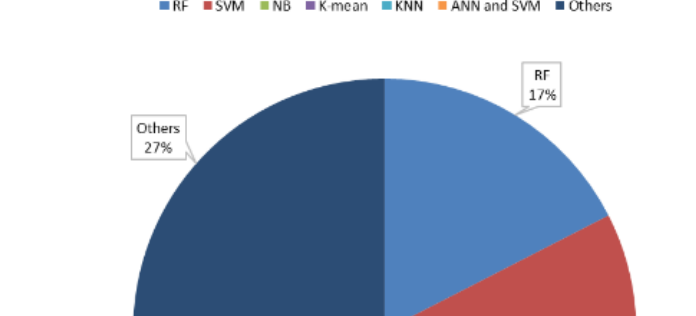
Figure 2. Classifier used.